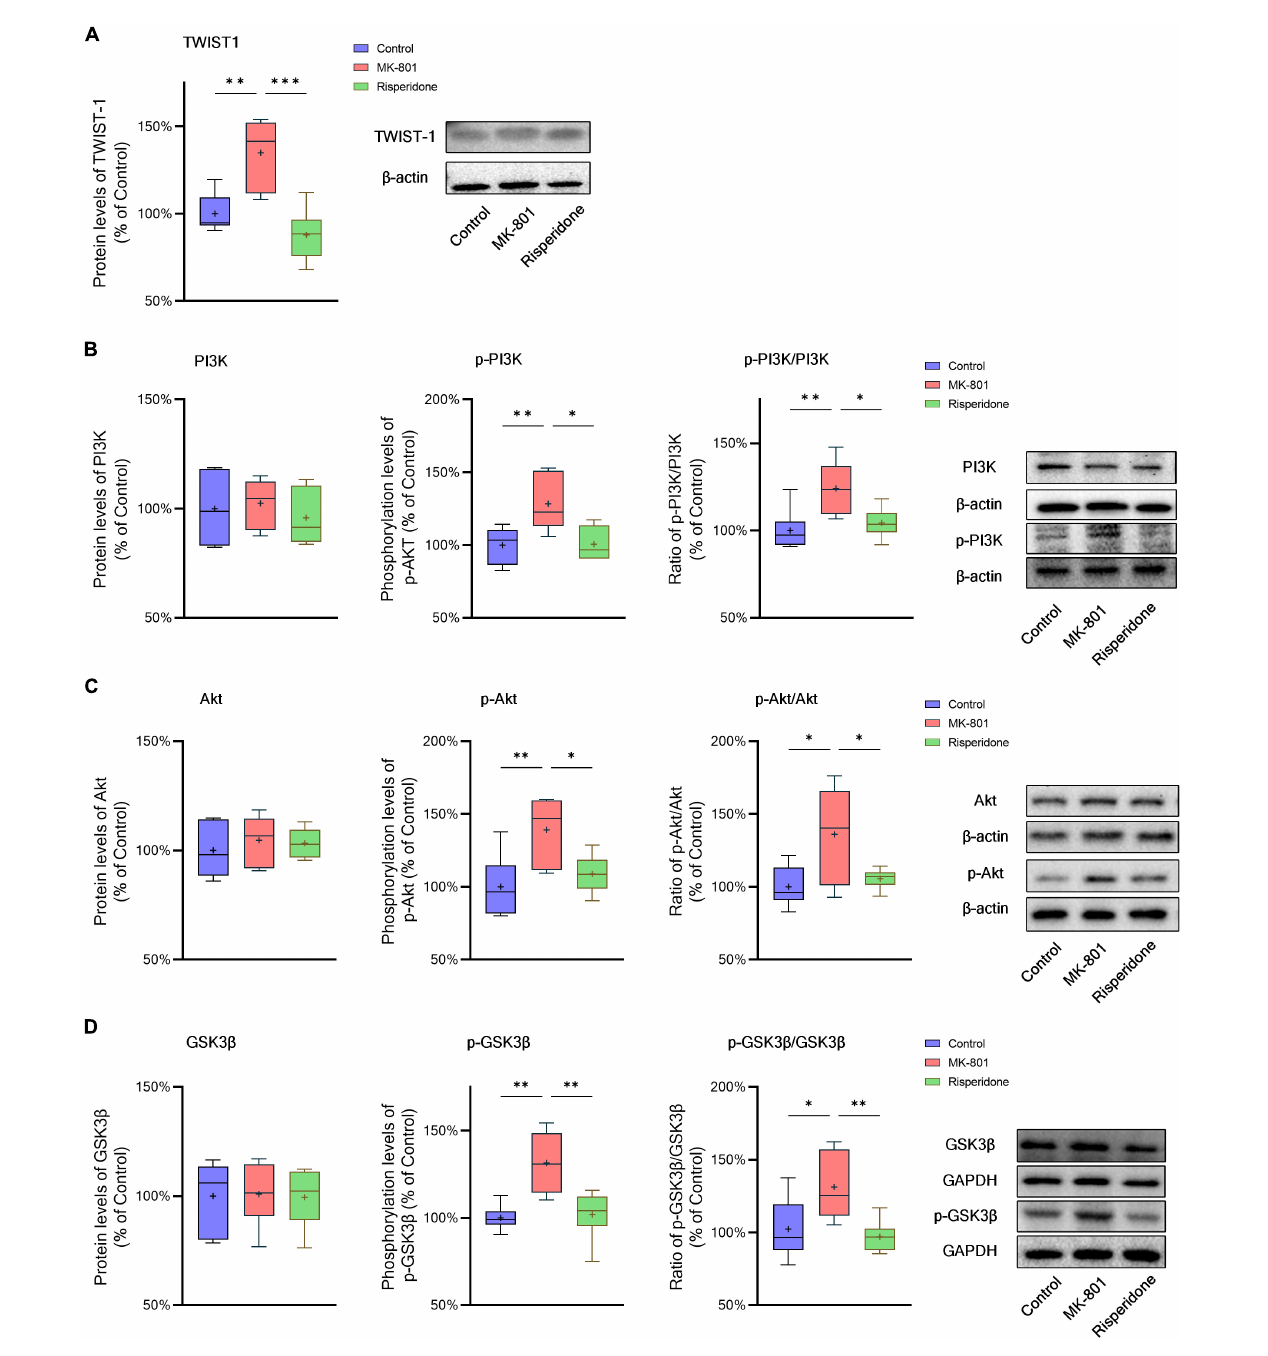
FIGURE5 Changed TWIST1/PI3K/Akt/GSK3 β signaling induced by the repeated MK-801 administration in the prefrontal cortex. (A) The protein expression of TWIST1 in the model rat prefrontal cortex (PFC) was inhibited, but returned to normal levels after administrating with risperidone. (B) The MK-801 administration reduced PI3K phosphorylation in the model rat PFC, which can also be reversed by risperidone. (C) The Akt activation in the model rat PFC was decreased, but up-regulated to near normal levels by risperidone. (D) The repeated MK-801 administration inhibited the GSK3 β phosphorylation in the model rat PFC, but restored by risperidone. ∗ P < 0.05, ∗∗ P < 0.01, ∗∗∗ P < 0.001, + mean